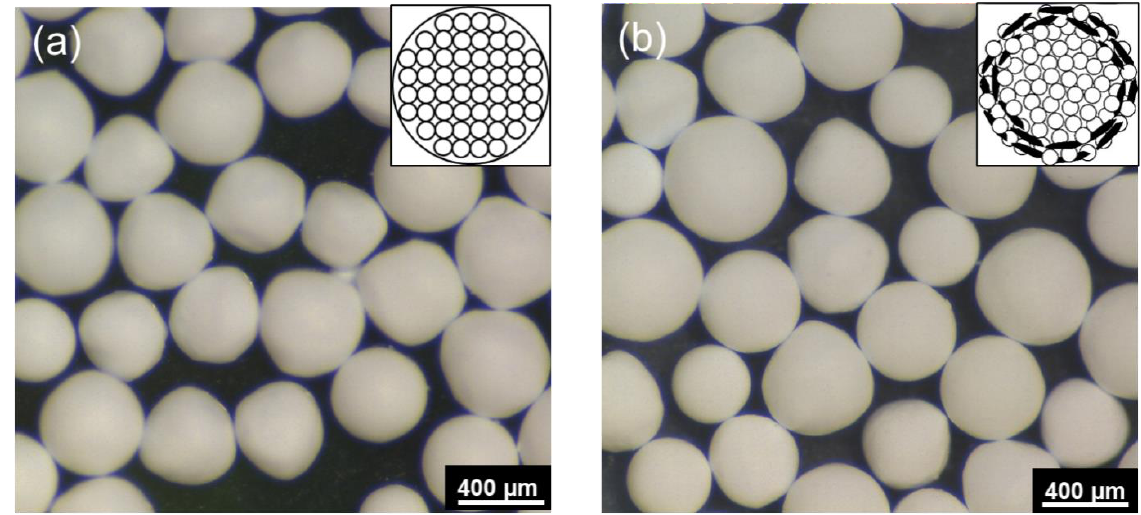
Figure 2. Optical microscope images of the dried ( a ) Al 2 O 3 granules and ( b ) Al 2 O 3 – hBN CS compo- sites granules. Insets are representative schematics for their internal microstructure.